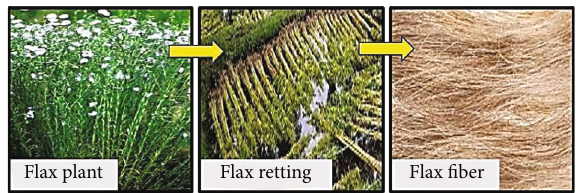
Figure 1: Flax fi bre abstraction from fl axseeds shrub.